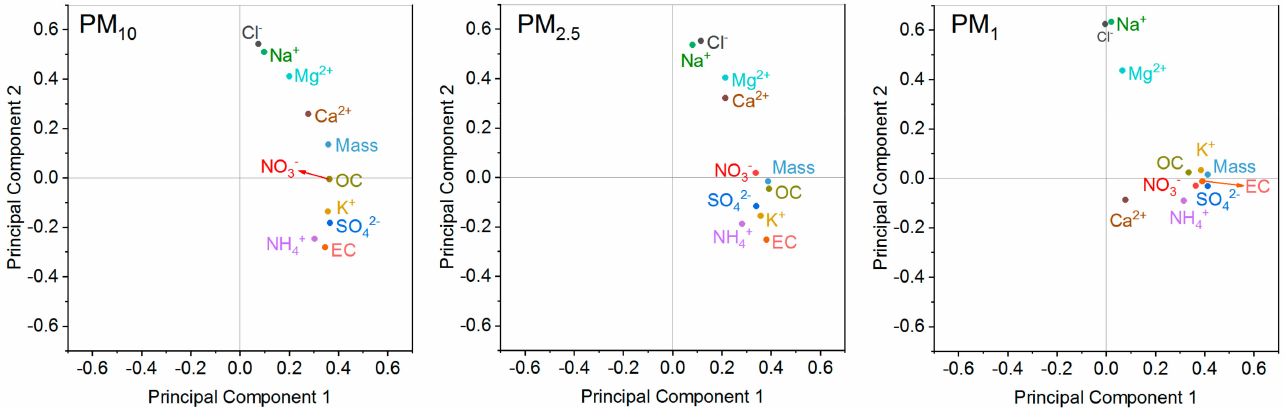
Figure 3. The results of principal component analysis of all measured species including mass, water-soluble ions, OC, and EC for PM 10 , PM 2.5 , and PM 1 during August 2007~February